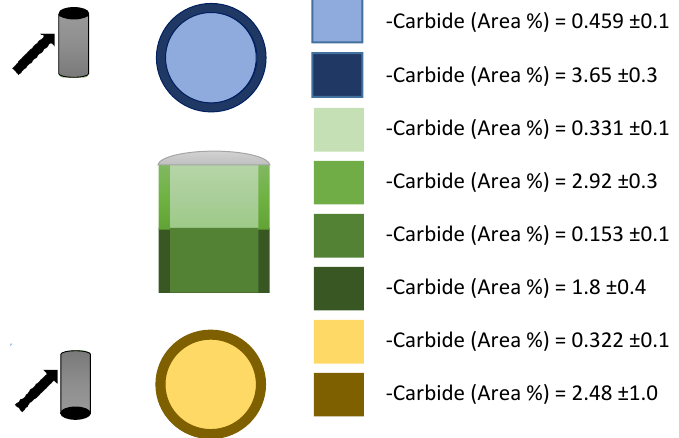
Figure 8. Carbide area percentage by region observed in both top and bottom horizontal cross-sections and the vertical cross-section of the HIPed specimen.